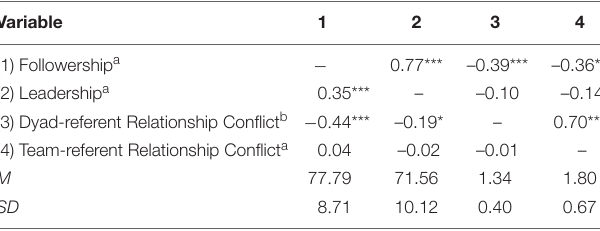
TABLE 1 | Descriptive statistics and intercorrelations between the